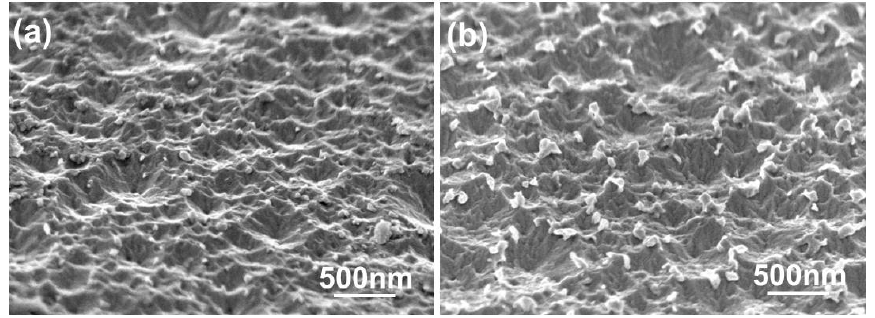
Figure 12. Surface morphologies of etched FZO films on ( a ) unmodified PI substrate and ( b ) PI substrate pretreated for 30 s.